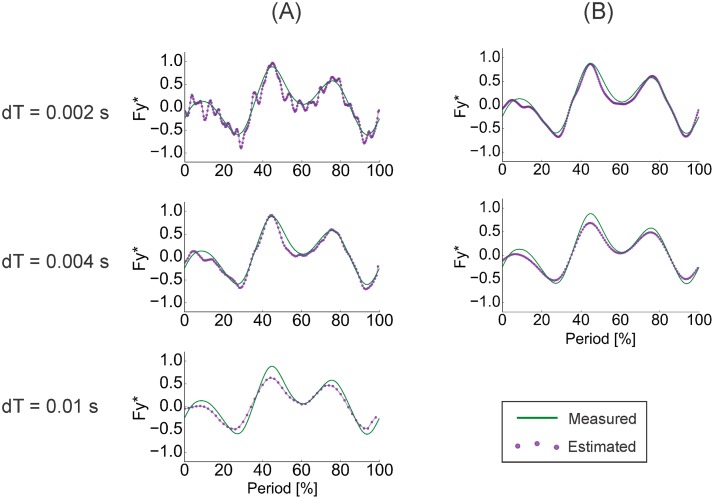
Time step selection for pressure field calculation.A comparison of the measured and calculated lateral force (Fy) values when the rectangular foil was operating in 0° angle of attack motions at 2.0 Hz actuation frequency under different time-steps. (A) The noise in the force trace from pressure-based force calculations decreased as time step (dT) increased. (B) When a low-pass filter was applied to the noisy time traces, nearly identical traces resulted, and these traces resembled the trace produced the time step was 0.01s. Streamwise forces (Fx) and vertical torques (Tz) followed similar trends to those displayed here.